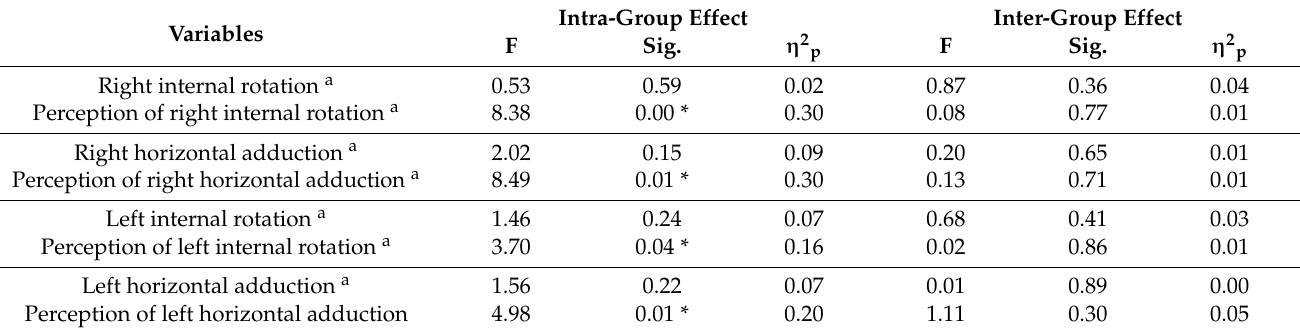
Table 4. Statistical analysis of repeated measures of the dependent variables in the three study assessments.